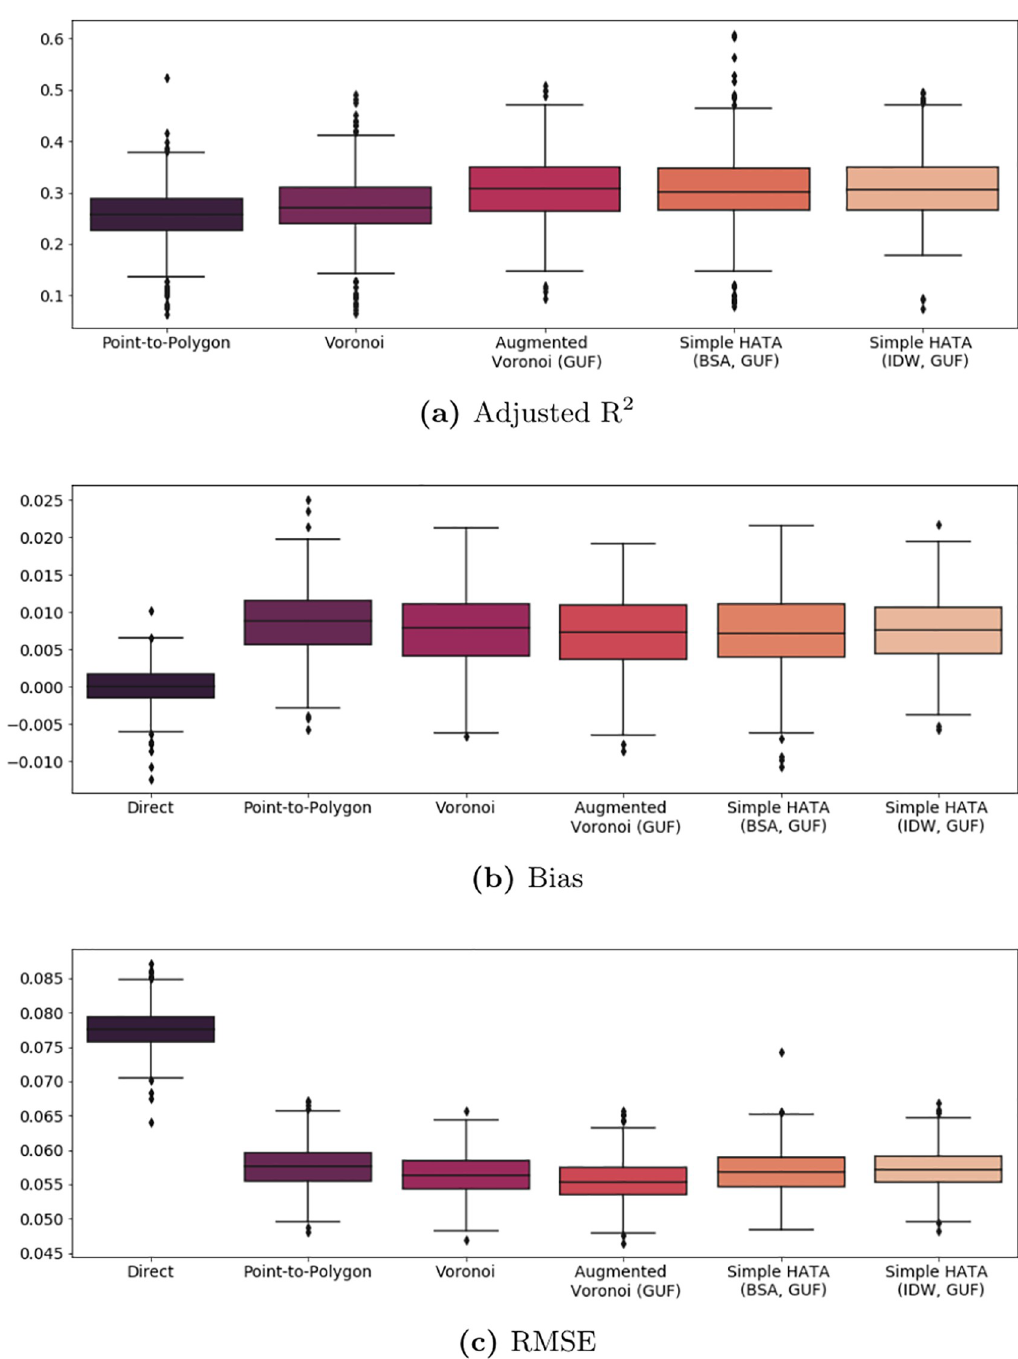
Fig 9. Evaluation of poverty rate estimates for in-sample communes. Distribution of the three performance metrics adjusted R 2 , bias and RMSE across 500 simulation runs on a comparable set of communes. The typical trade-off between the bias and the variance of a small area estimator vis- à -vis the direct survey estimator becomes apparent.